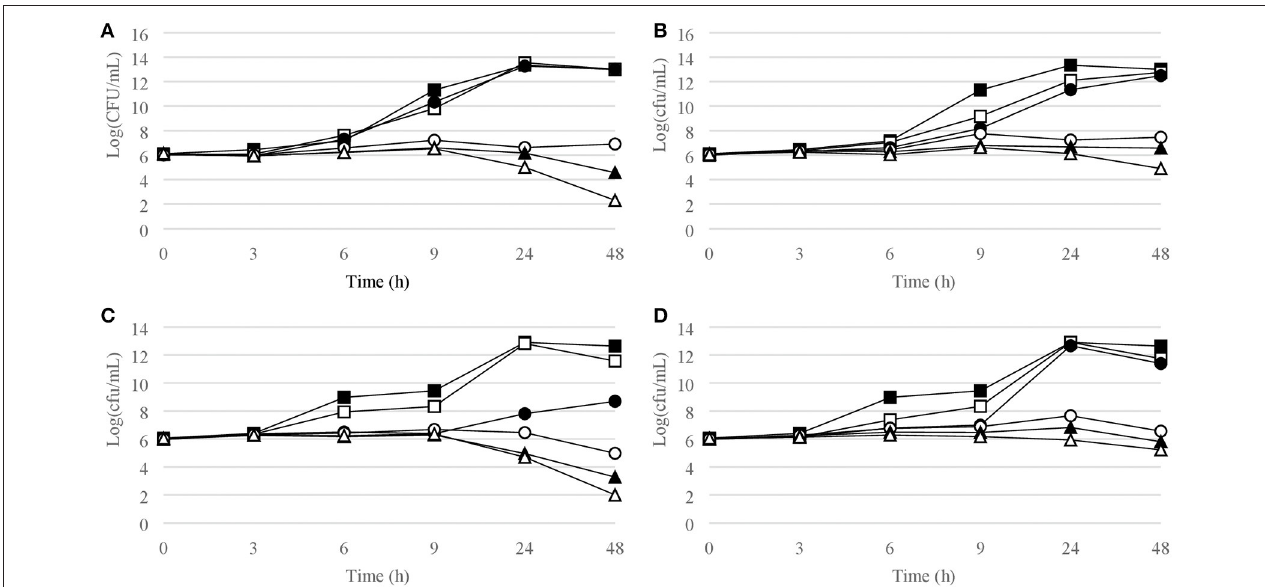
FIGURE 2 | Time-kill curves for S. aureus . (A) chlorquinaldol, MSSA; (B) fusidic acid, MSSA; (C) chlorquinaldol, MRSA; (D) fusidic acid, MRSA. Filled square, control; open square, ¼ × MIC; filled circle, ½ × MIC; open circle, 1 × MIC; filled triangle, 2 × MIC; open triangle, 4 × MIC.